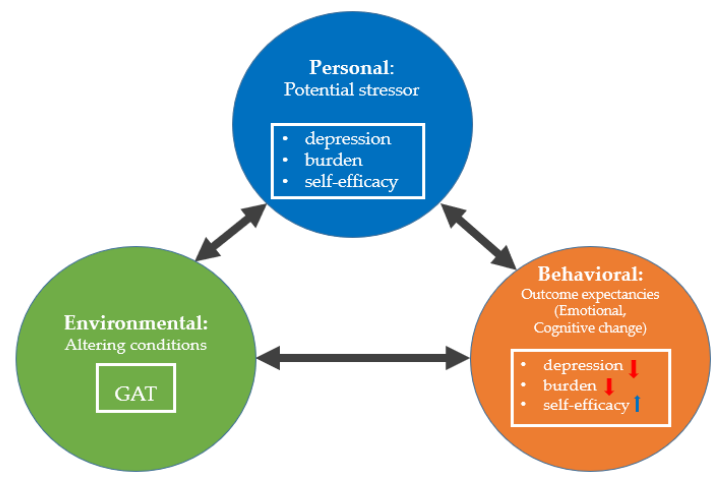
Figure 1. Theoretical framework. GAT refers to group art therapy.